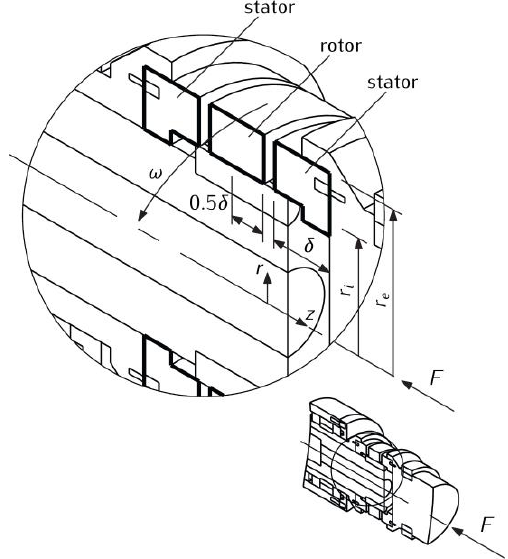
Figure 1. Schematic diagram of the friction pair on the test rig.